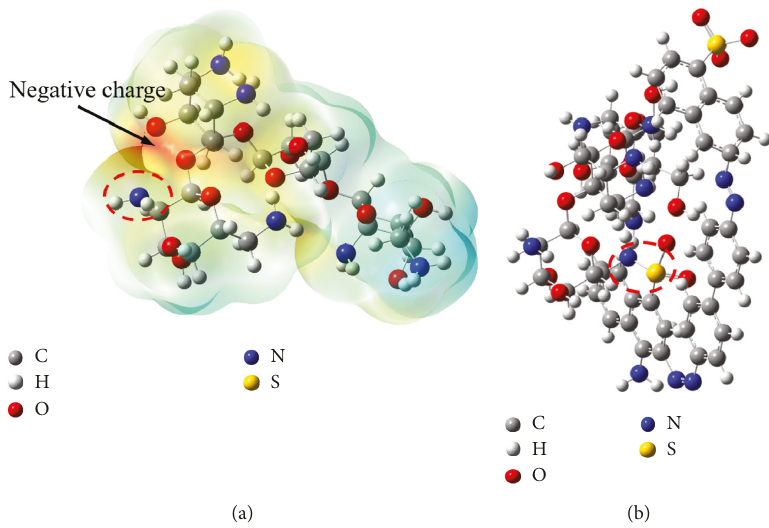
Figure 7: Neomycin electrostatic potential distribution and structure diagram of Congo red-neomycin system. (a) The orbital charge distribution and electrostatic potential of the natural bond of neomycin. (b) The structural diagram of the congo red-neomycin system.